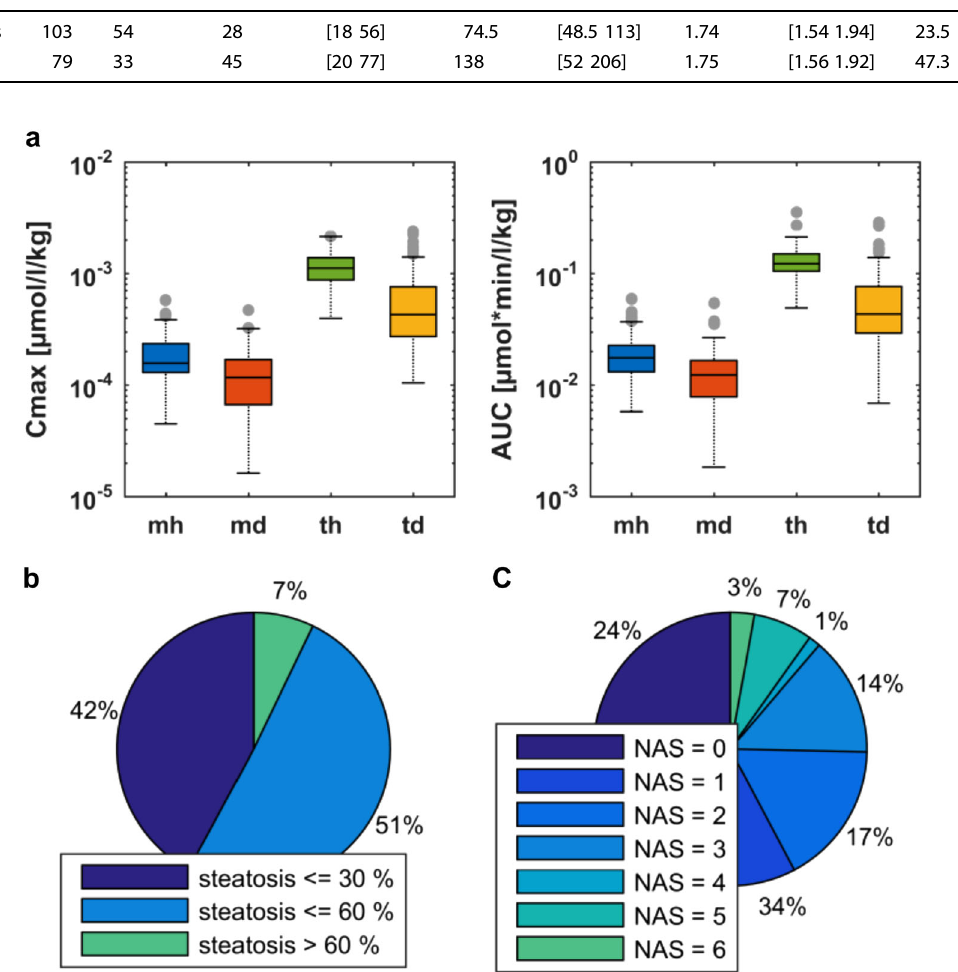
Fig. 2 Evaluation of experimental PK data and individual metadata for midazolam and torsemide in healthy individuals and diseased patients. a Boxplots of Cmax and AUC for healthy individuals and diseased patients treated with midazolam or torsemide. b Fractions of individuals with different levels of steatosis. c Fractions of individuals with different NAS. Blue indicates midazolam data from healthy population (mh); green torsemide data from healthy population (th); red midazolam data from diseased population (md); yellow torsemide data from diseased population